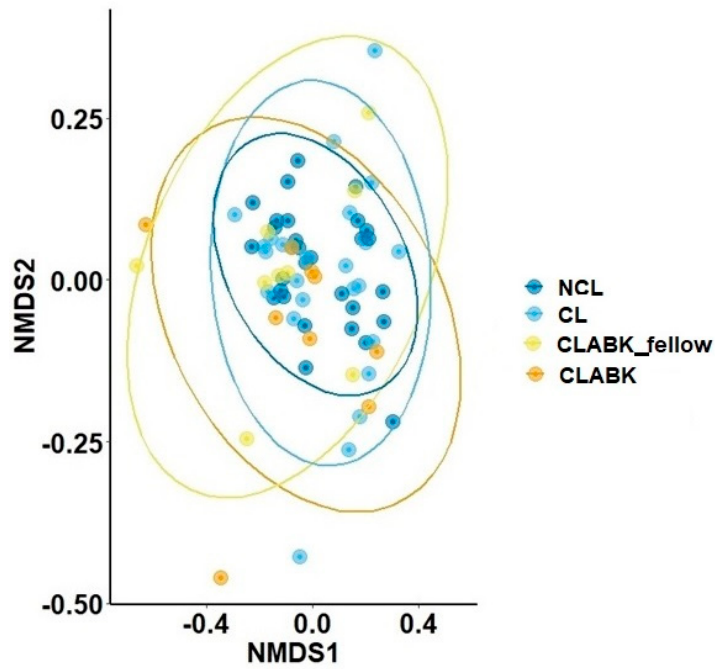
Figure 1. Comparison of the bacterial composition of ocular surface microbiota using the Bray–Curtis dissimilarity index for the study population. The bacterial composition was compared at the amplicon sequence variant (ASV) level and visualized in a two-dimensional plot with nonmetric multidimensional scaling (NMDS). Conjunctival samples from both eyes of the patients with contact-lens-associated bacterial keratitis (eye with bacterial keratitis (CLABK) and the eye without bacterial keratitis (CLABK_fellow)) were compared with one randomized eye for each participant in the following groups: contact lens users without bacterial keratitis (CL) and non-contact-lens users (NCL). The bacterial composition was not significantly different between groups (pairwise comparison with PERMANOVA); NCL vs. CL p = 1.0; NCL vs. CLABK_fellow p = 0.49; NCL vs. CLABK p = 0.35; CL vs. CLABK_fellow p = 1.0; CL vs. CLABK p = 0.82. Stress ratio =